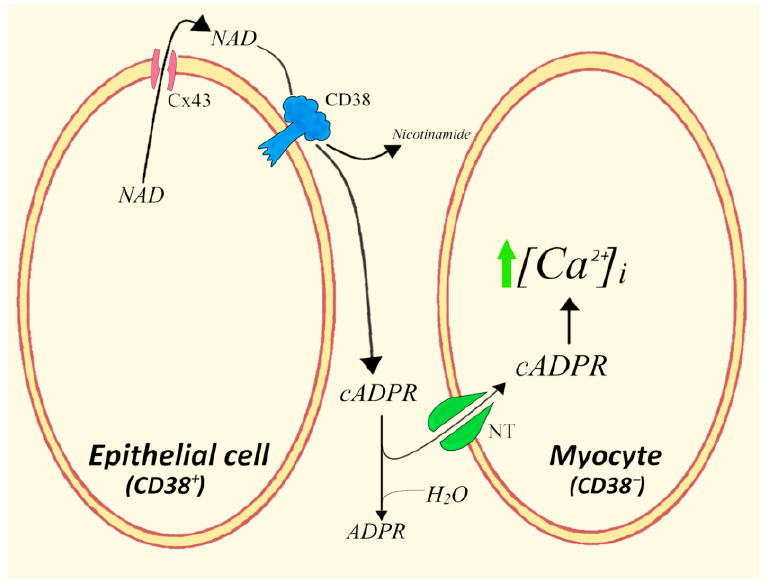
Figure 3. Paracrine roles of NAD + /cADPR from epithelial cells in eliciting Ca 2+ responses in smooth myocytes. NT, nucleoside transporters; Cx43, connexin 43.